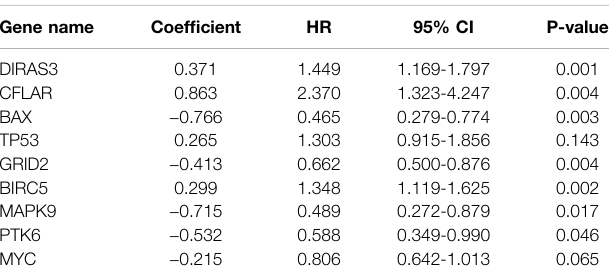
TABLE 2 | ARGs associated with